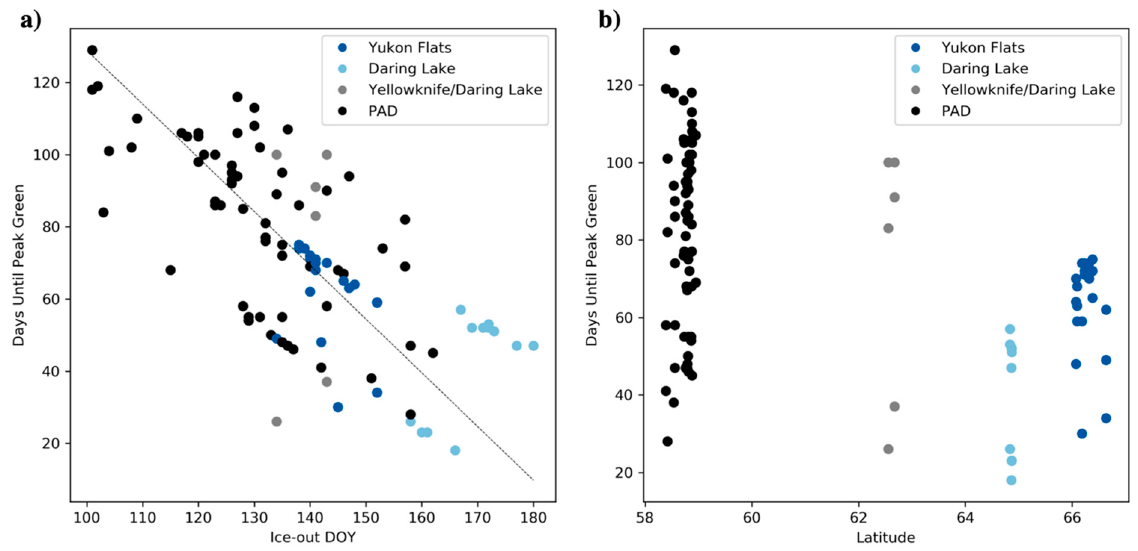
Figure 6. ( a ) relationship between the ramp up, defined as the number of days between ice-out and peak green, and the ice-out day of year (type II regression, y = − 1.65x + 307.06, r 2 = 0.35) ( b ) relationship between the number of days since ice-out until peak green with latitude (type II regression, y = − 6.95x + 486.59, r 2 = 0.29).